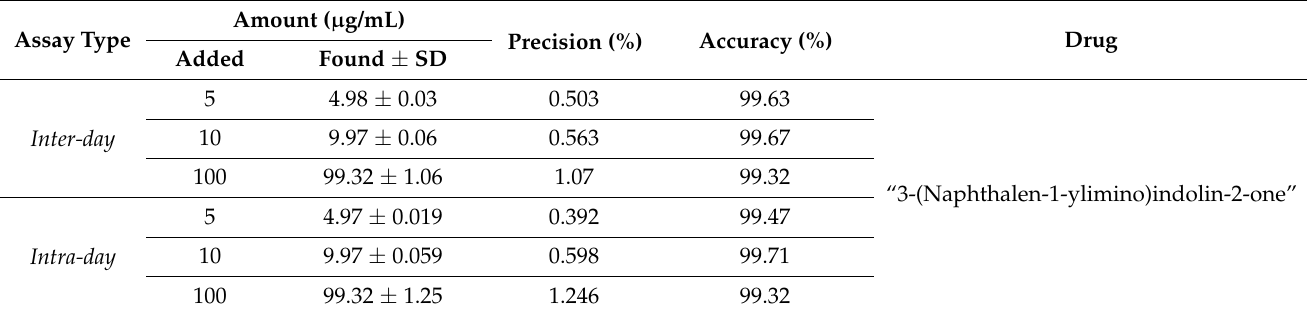
Table 2. Evaluation of accuracy and precision of the proposed method for the simultaneous determination of “3-(Naphthalen- 1-ylimino)indolin-2-one”, by Inter-day and Intr-day assay. Assay